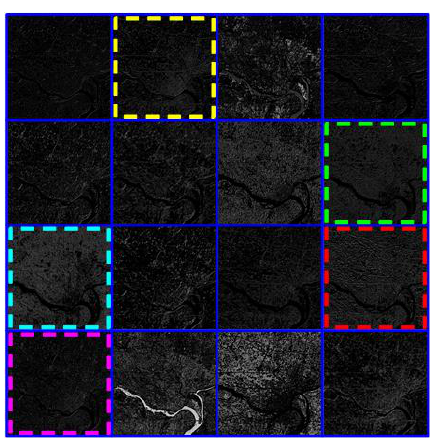
Figure 3. Deep feature map examples of two images with non- linear radiometric difference. (a) shows the blue band image and near-infrared band image of a Landsat8 image. (b) and (c)